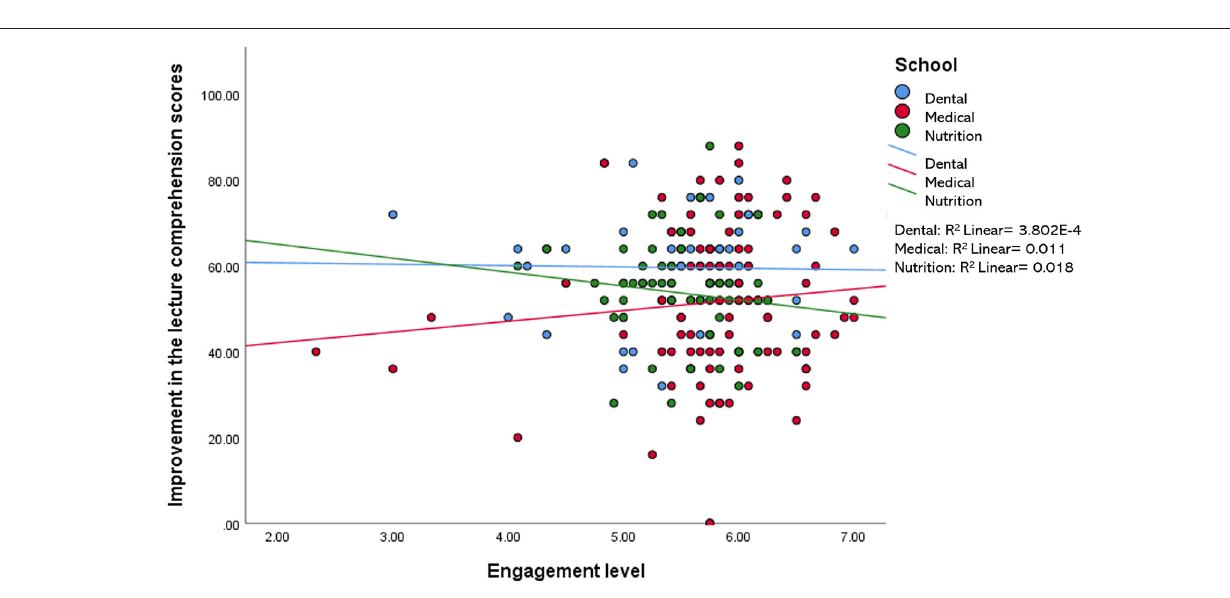
FIGURE 6 | Improvement of the lecture comprehension scores vs. the students’ engagement level after the CLT-based online